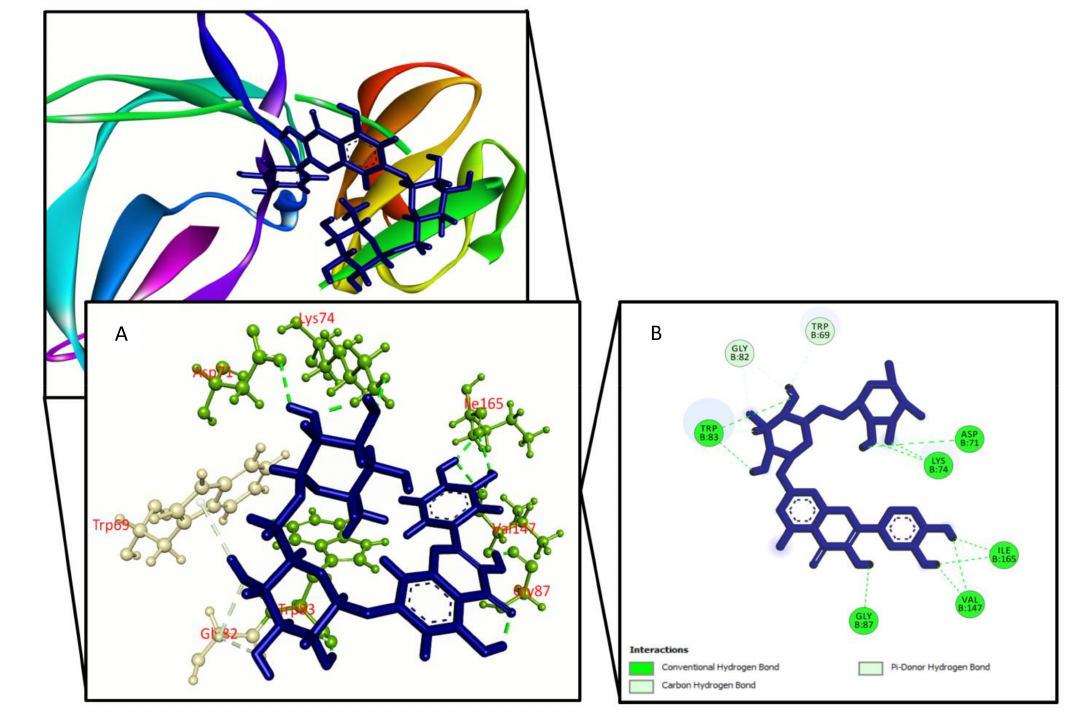
Figure 3. Quercetin-7- O -rutinoside binding the Dengue virus NS2B/NS3 protease (PDB: 2FOM), ( A ) 3D representation and ( B ) 2D representation. Hydrogen bonds are displayed as green ball and stick, carbon–hydrogen bonds are displayed as white ball and stick.